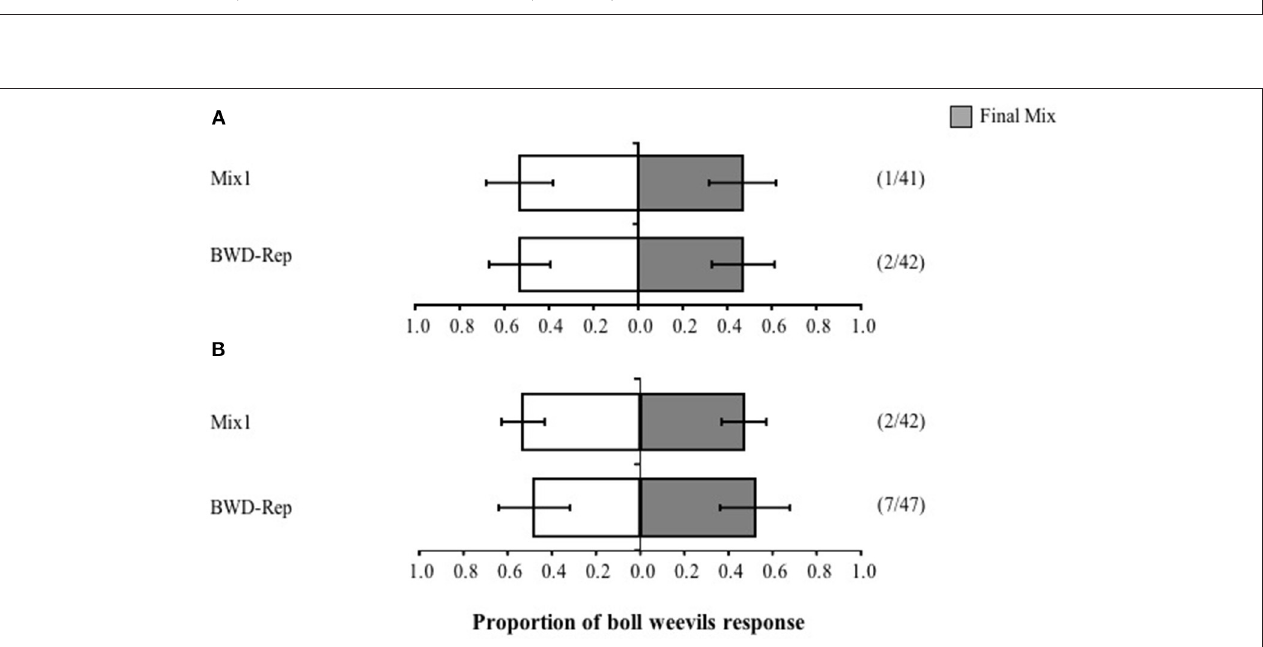
FIGURE 8 | First choice of male (A) and female (B) boll weevils, Anthonomus grandis , in a Y-tube olfactometer to synthetic blends at the same concentration and ratio as volatile samples collected from boll weevil-damaged cotton plants at the reproductive stage (for composition of blends, see Table 1 ). BWD-Rep = volatile samples collected from boll weevil-damaged cotton plants at the reproductive stage. Bars indicate 95% of confidence interval. Numbers in parentheses indicate insects that did not respond to either tested treatments/total amount of bioassays.